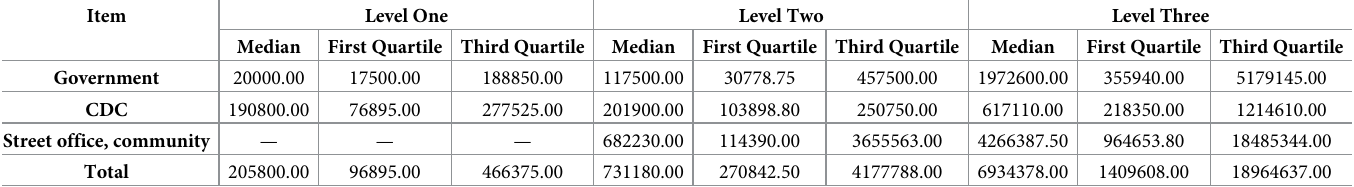
Table 5. Organizational cost for prevention and treatment of dengue fever (CNY).